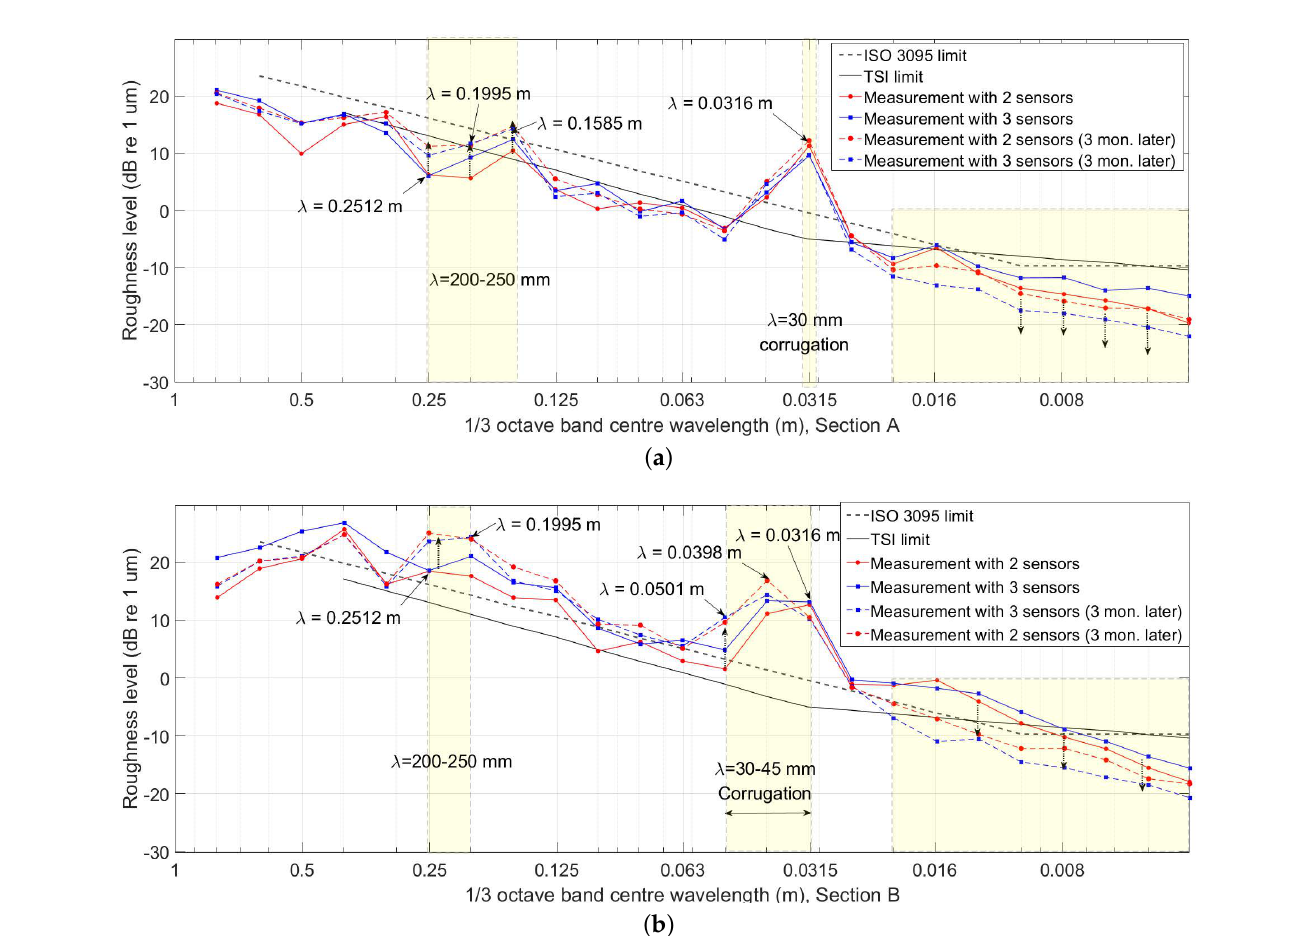
Figure 9. Spectralum changes in railhead roughness on operational field track over 3 month period: ( a ) Section A, ( b ) Section